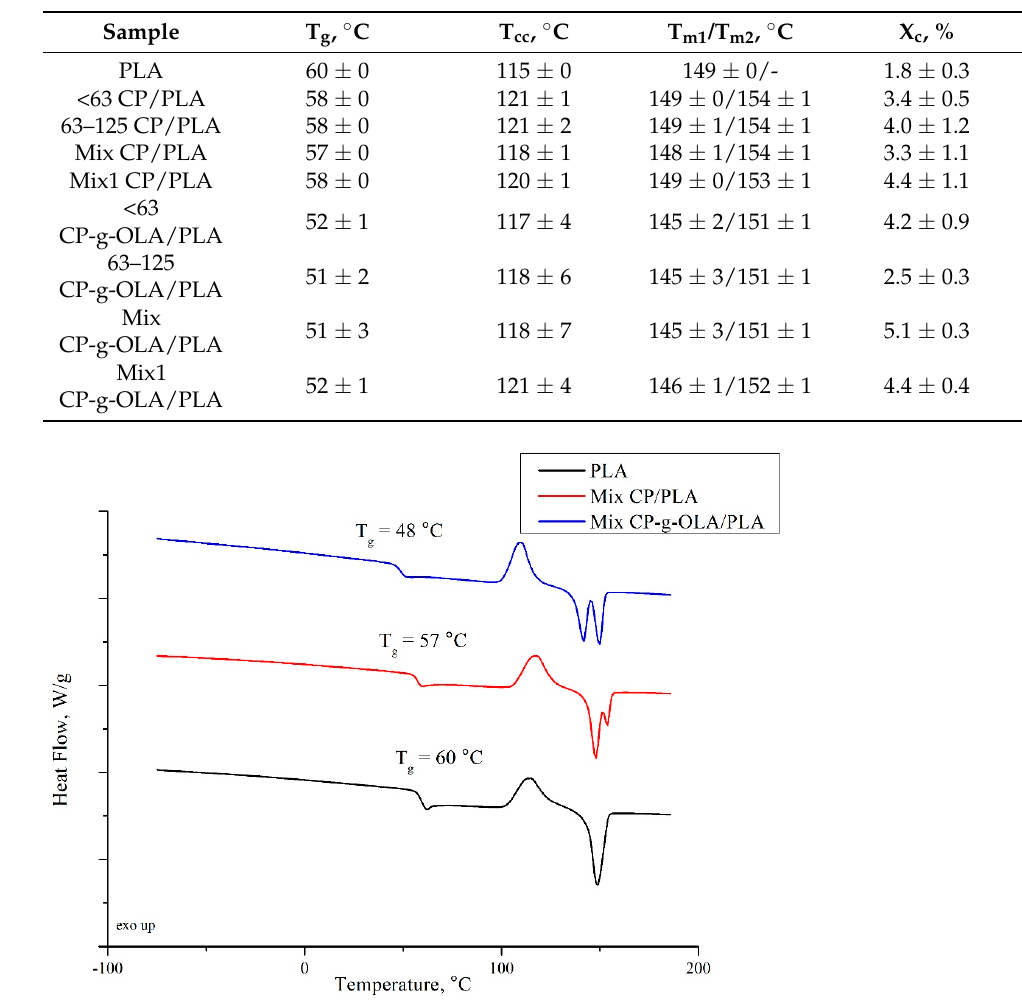
Table 10. Results of DSC analysis.